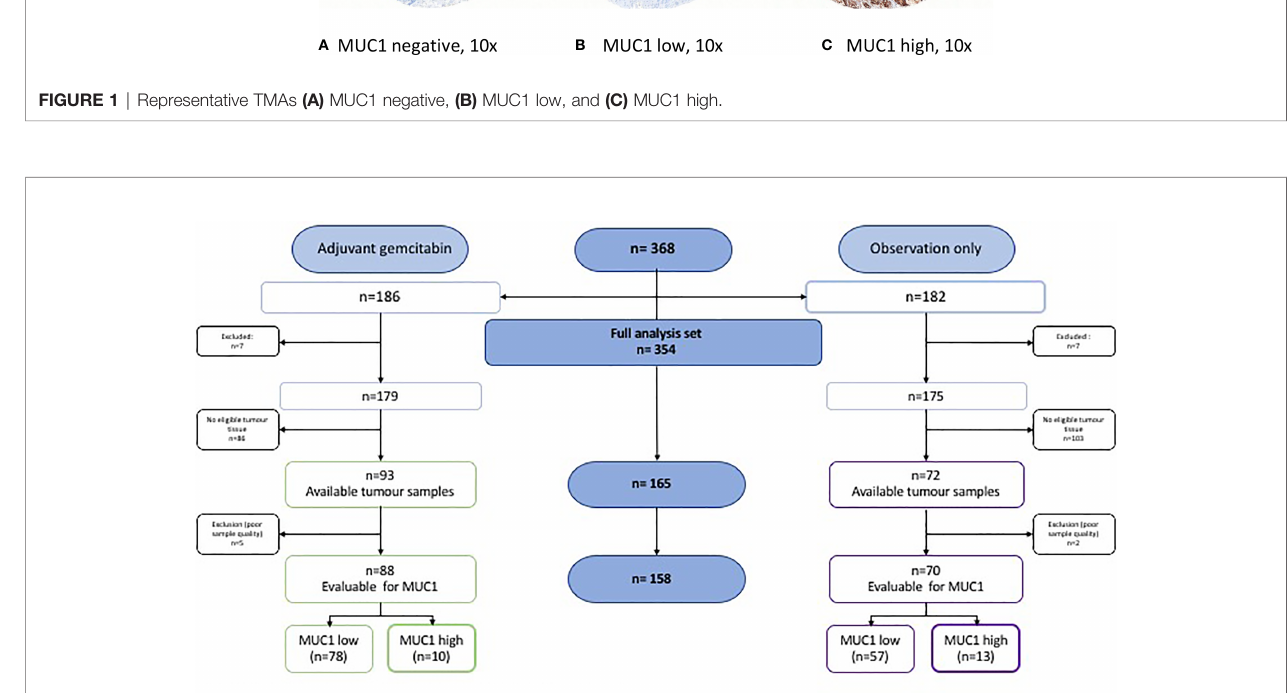
FIGURE 2 | CONSORT diagram MUC1 in CONKO